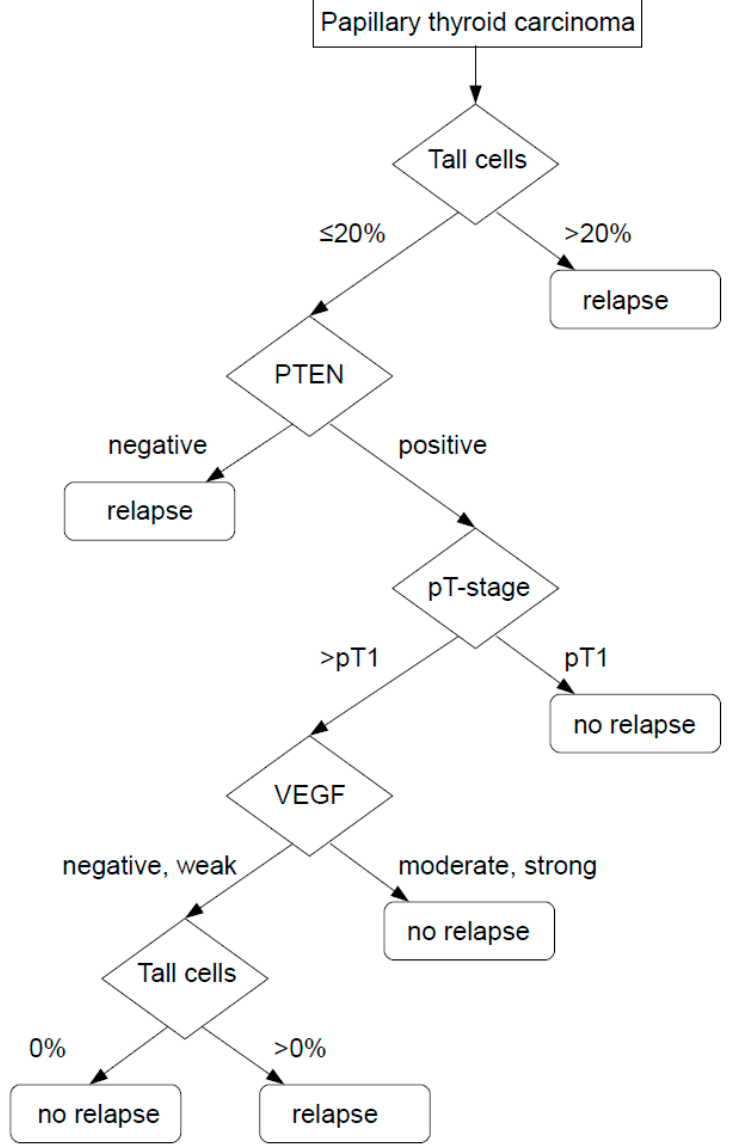
Figure4. Figure 4. decision tree with TC, PTEN, VEGF and pT-stage to determine RFS in PTC, overall accuracy 79.2%.